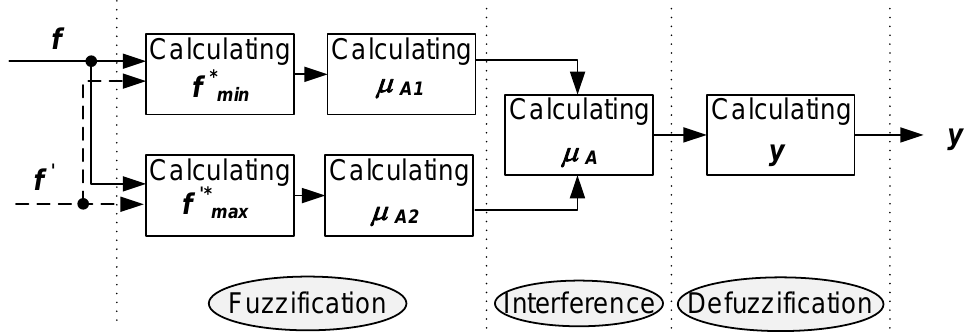
Figure 2. Flowchart of the fuzzy adaptive underfrequency load shedding (UFLS; y is the number of load groups to be disconnected).